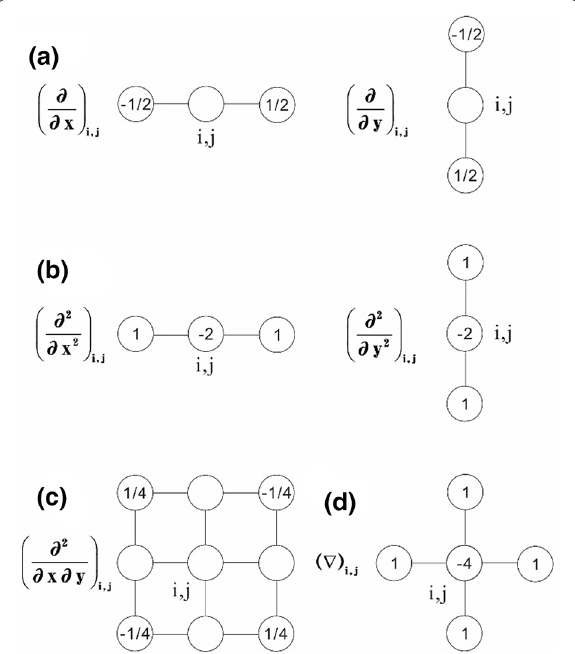
Fig. 14 Schematic diagram of the node operation for the central difference operators. a First‑order differential operations. b Second‑order differential operations. c Second‑order mixed partial differential operations. d Laplace differential operations. Null nodes indicate zero